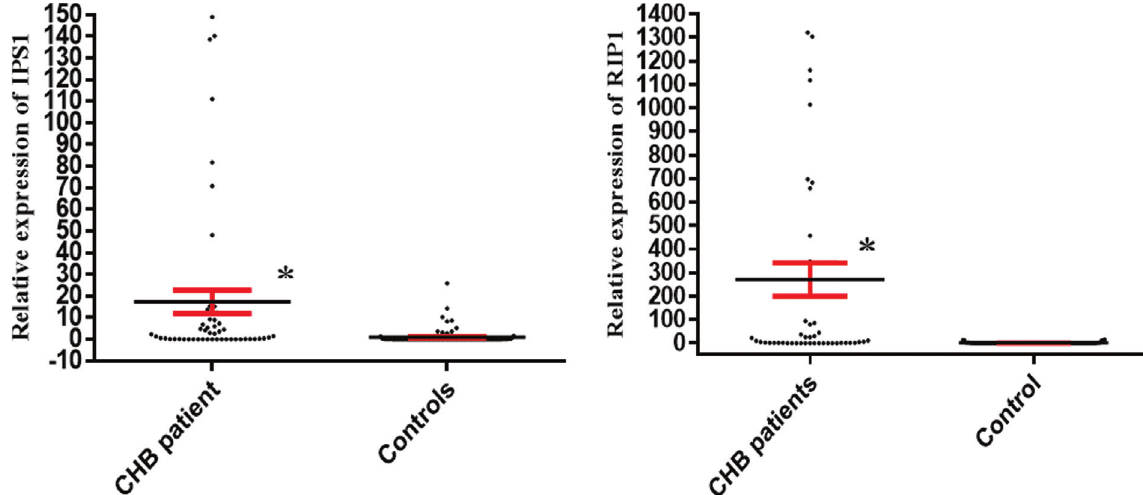
Figure1 - IPS-1 and RIP1 geneexpressioninpatientswithchronichepatitisBandcontrols.IPS-1andRIP1mRNAlevelsweresignificantlyincreasedin patients when compared to healthy controls. Data are presented as mean (cid:4) standard errors. The results regarding the expression levels of IPS-1 and RIP1 are reported as fold-changes (Ebrahim et al. , 2015). * p- value <